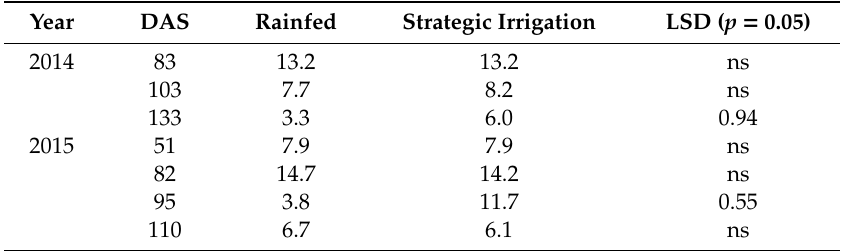
Table 3. Average leaf photosynthetic rate (A) ( µ mol / m 2 / s) of rice varieties under strategic irrigation and rainfed conditions at Alton Downs in 2014 and 2015. DAS = days after sowing. DAS Rainfed Strategic Irrigation LSD ( p = 0.05)